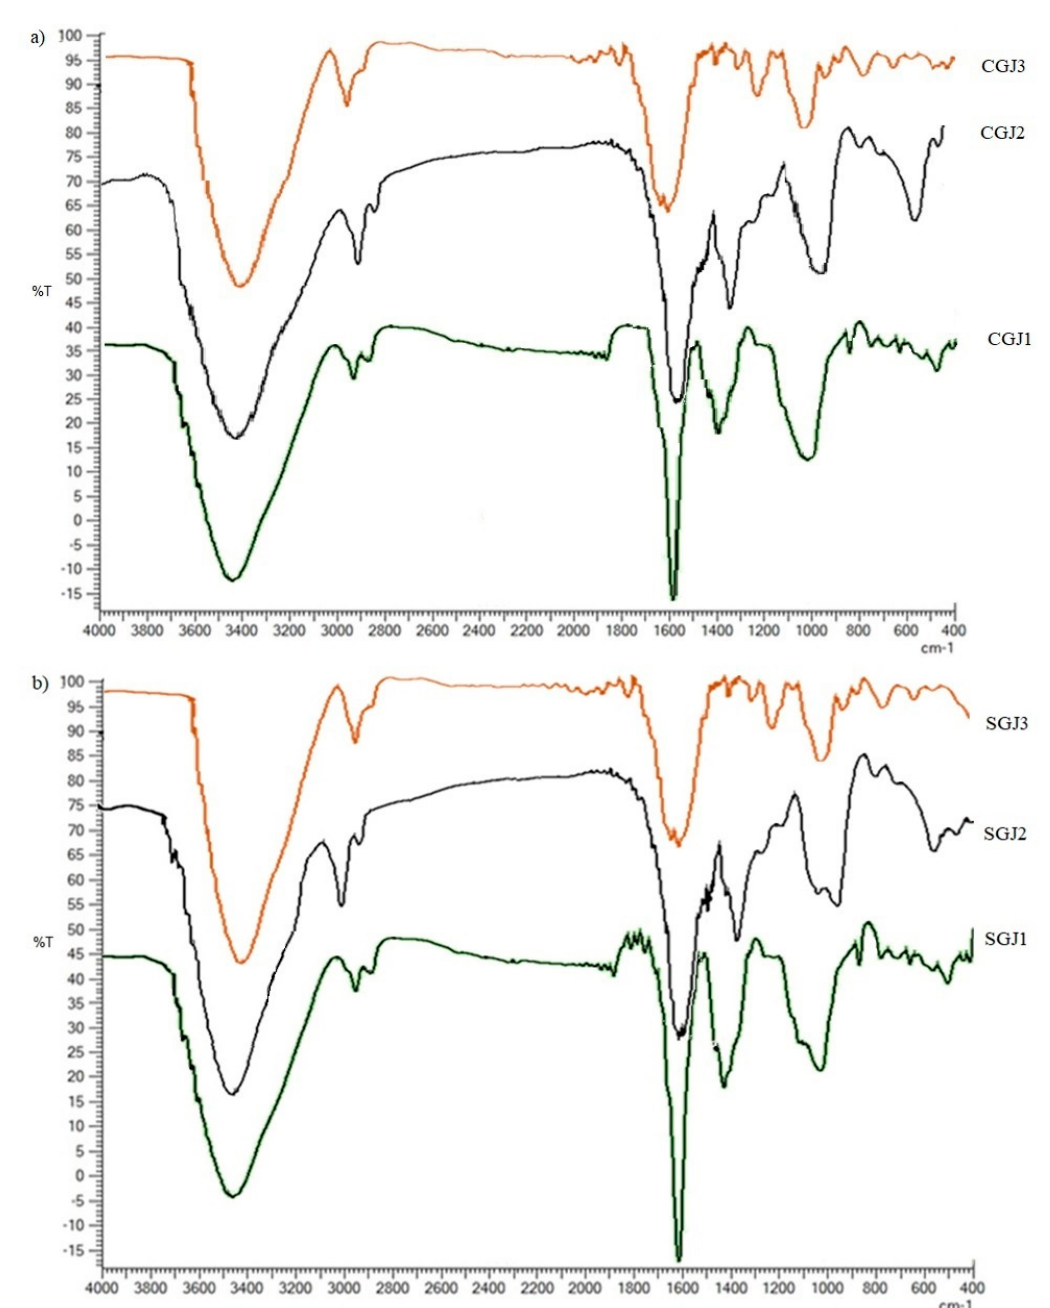
Figure 3. The Fourier transform infrared spectra (FT-IR) of crude ( a ) and soluble ( b ) glucans. CGJ1 (crude glucans from jujubes of first harvesting); CGJ2 (crude glucans from jujubes of second harvesting); CGJ3 (crude glucans of jujubes at third harvesting); SGJ1 (soluble glucans from jujubes of first harvesting); SGJ2 (soluble glucans from jujubes of second harvesting); SGJ3 (soluble glucans from jujubes of third harvesting).